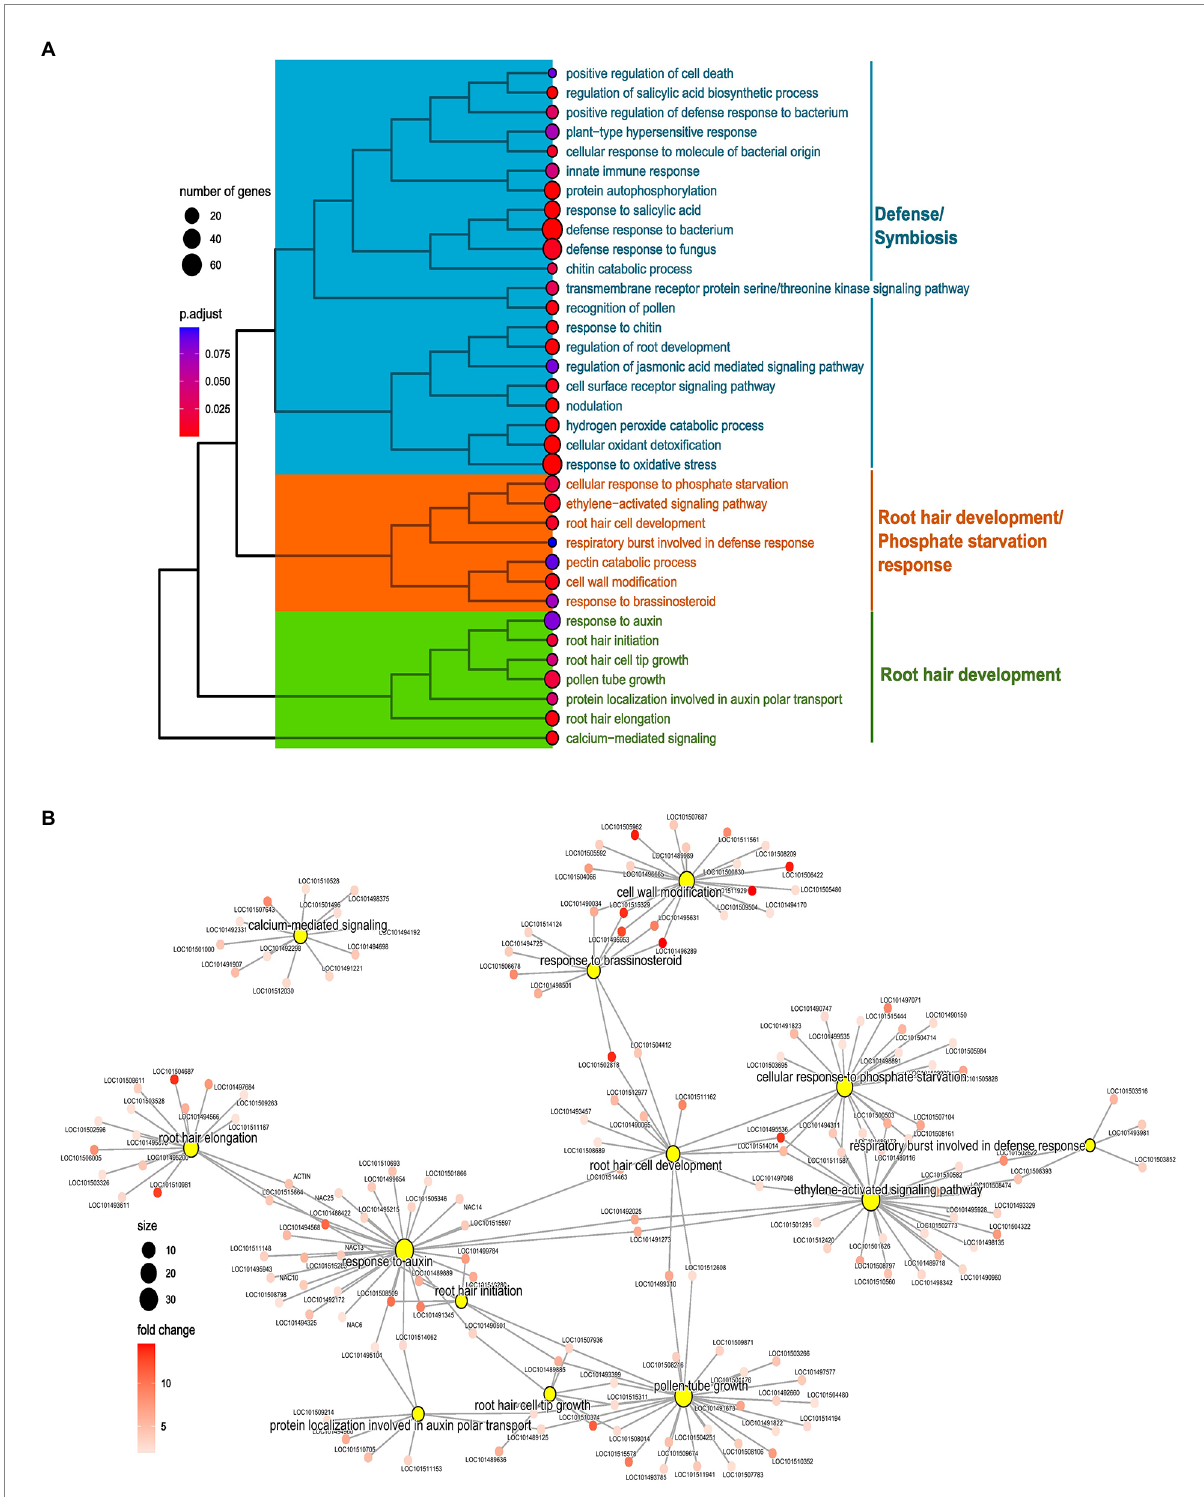
FIGURE 5 Enrichment analysis of preferentially expressed genes in root hairs (RH) in normal phosphorus (NP, NPRH vs. NPRT). (A) Tree plot representing the clustering of enriched terms of biological processes (BPs) for preferentially expressed genes in RH in NP. The terminal branch of the tree represents an enriched term, and the size of the dot depicts the number of genes assigned from the preferential gene set to that term. The color represents the adjusted value of p of the enrichment. The tree plot is clustered and categorized into three clusters. The functionality that each cluster represents is denoted on the left-hand side. (B) Network of BP terms (central nodes) and the preferentially expressed genes (sub-nodes) from the orange and green clusters. The size of the central nodes represents gene count, and the color gradient of sub-nodes depicts fold change of preferentially expressed